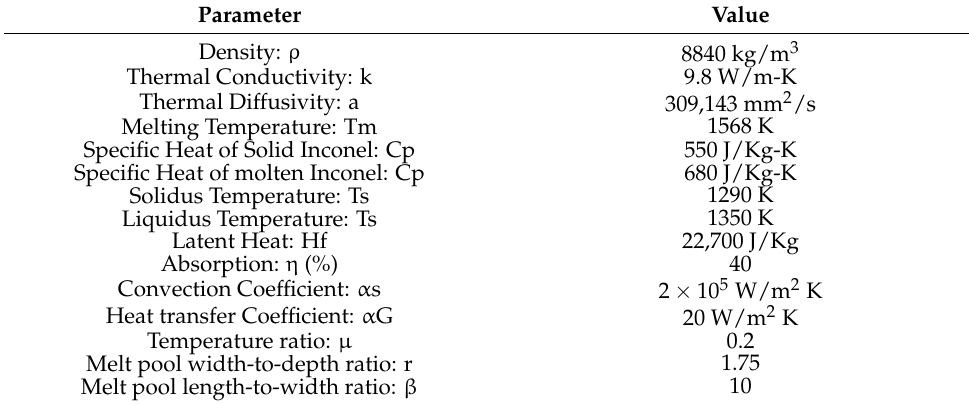
Figure 3. Intra-layer disturbance model. The last track receives heat. The heat coming from previous tracks increases the initial temperature of the current track being scanned. The simulations were conducted on Inconel 625 metal, and the thermal properties of Inconel 625 are adopted from [28,65]. The Inconel 625 and other simulation data are listed in Table 2. The thermal conductivity k and specific heat Cp values are temperature dependent. Their values vary from 25 ◦ C to melting temperature, so we have considered the average values of these parameters in the simulation. Table 2. The material properties of Inconel 625 and melt pool